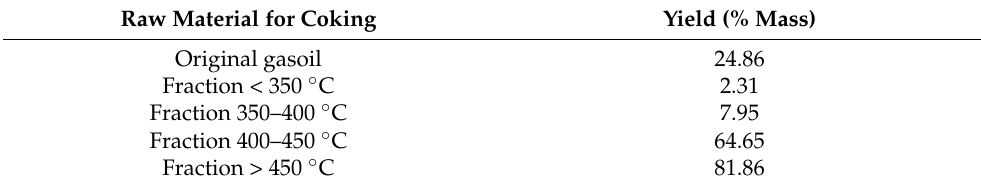
Table 8. The yield of coke measured on the laboratory setup.